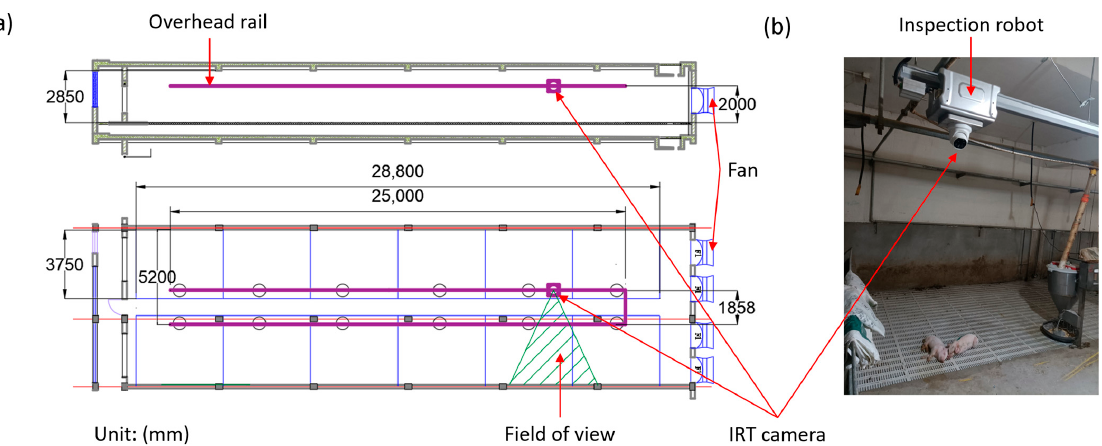
Figure 3. Infrared thermography system in pig building. Geometry of the system ( a ) and a photo of the inspection robot ( b